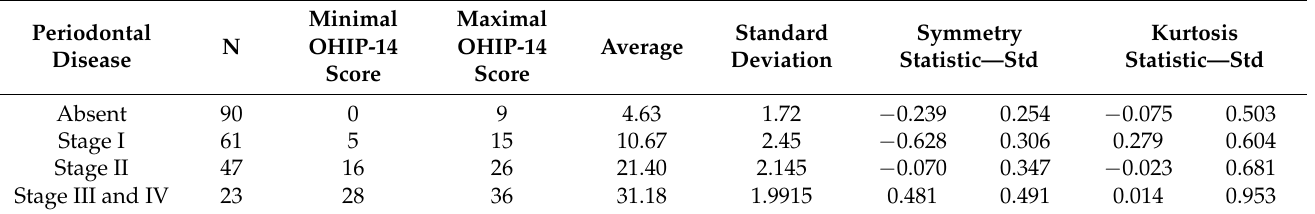
Table 2. Descriptive indicators for the OHIP questionnaire in the function of the severity of the periodontal